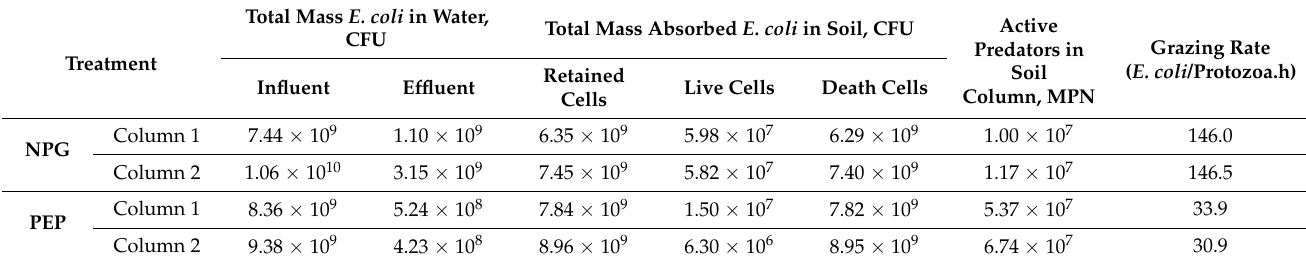
Total Mass Absorbed E. coli in Soil, CFU Active